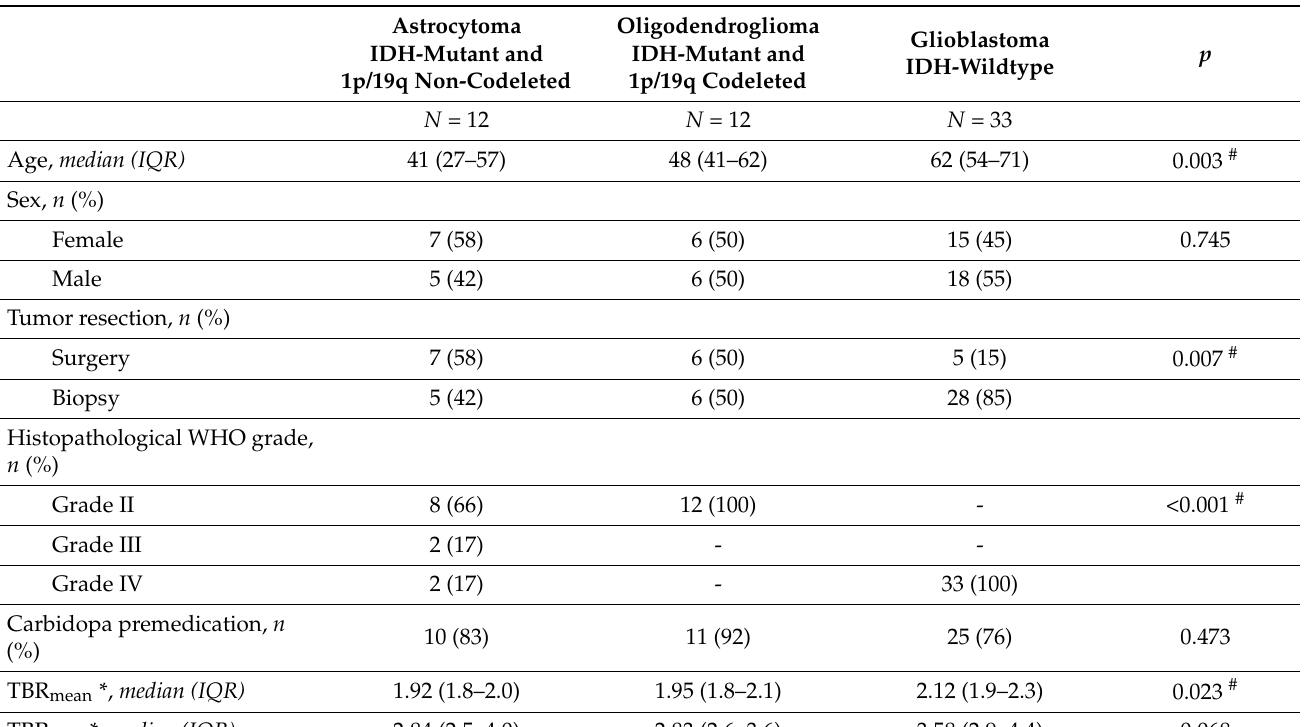
Table 1. Patient